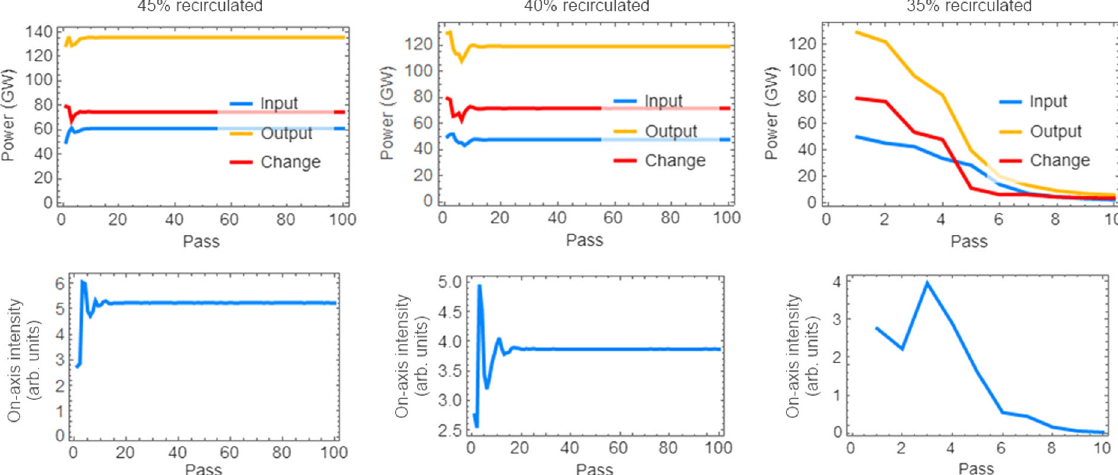
FIG. 10. Recirculation simulation using a full 3D model. The output Genesis field is recirculated via Huygens-Fresnel